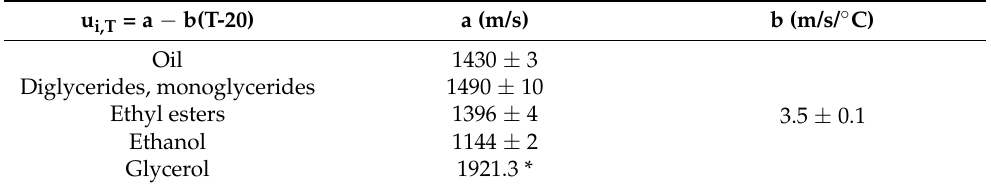
Table 3. Estimated values for speed of sound propagation of pure components.